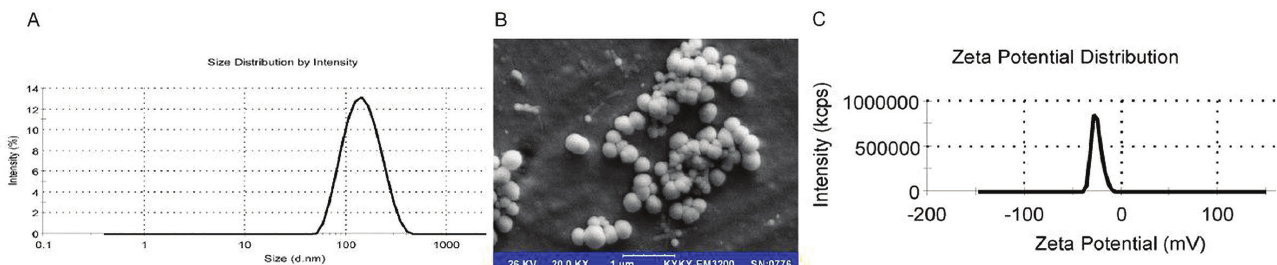
FIGURE 1 - Characterization of paclitaxel albumin-bound nanoparticles: A) Particle size distribution by intensity; B) Scanning